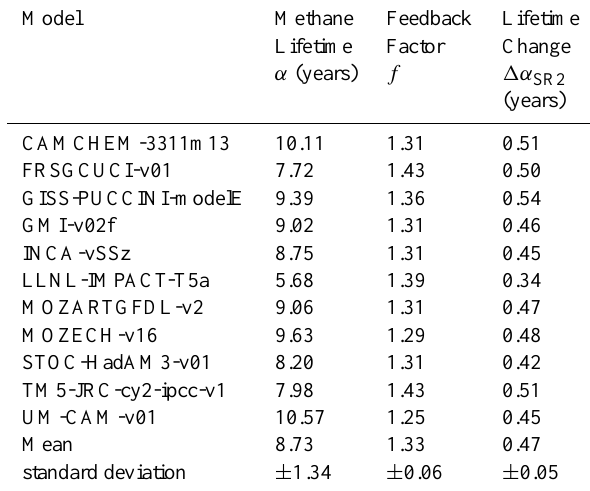
Table 1. HTAP ozone precursor anthropogenic reduction experi- ments. In the case of SR2, methane mixing ratios are reduced by 20%; for SR3–SR5 emissions of the precursor are reduced. The re- gions are defined as follows: North America (NA), 15–55 ◦ N, 60– 125 ◦ W; South Asia (SA), 5–35 ◦ N, 50–95 ◦ E; East Asia (EA), 15–